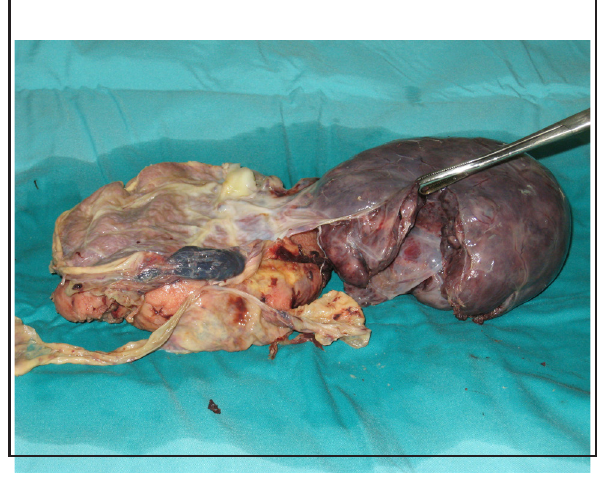
Figure 2. Chorioangioma attached to the fetal surface of the placenta. Gross: Placenta weighing 1100 grams measures 17x12x3 cm 3 with an attached soft tissue mass measuring 12x11.5.5 cm 3 . The cut section of the mass appears dark brown. Only a stump of cord is attached to the fetal surface of the placenta.The membranes appear unremarkable .The cut section of the placental disc appears unremarkable. Microscopy: Sections show a neoplasm comprising proliferation of capillary sized and occasional cavernous vessels surrounded by connective tissue